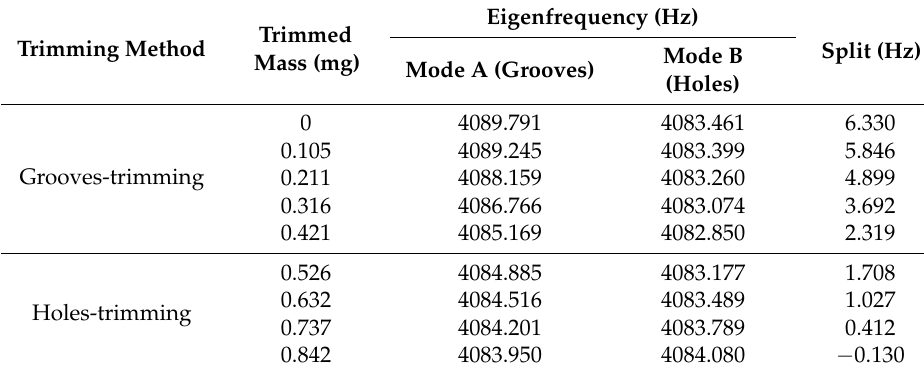
Table 3. Trimming process in our simulation.